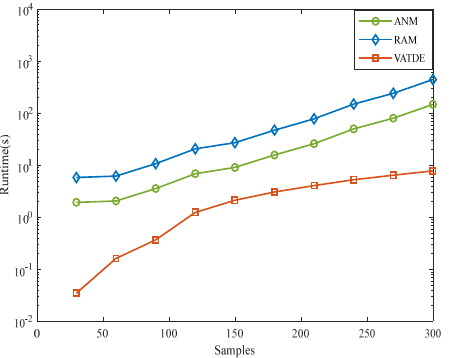
Figure 5. Running time under different numbers of sampling